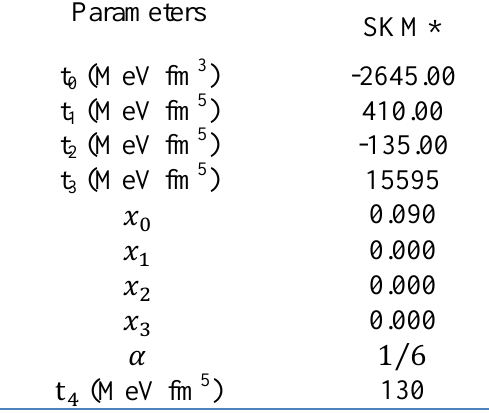
Table 1: Skyrme parameterization used in the present